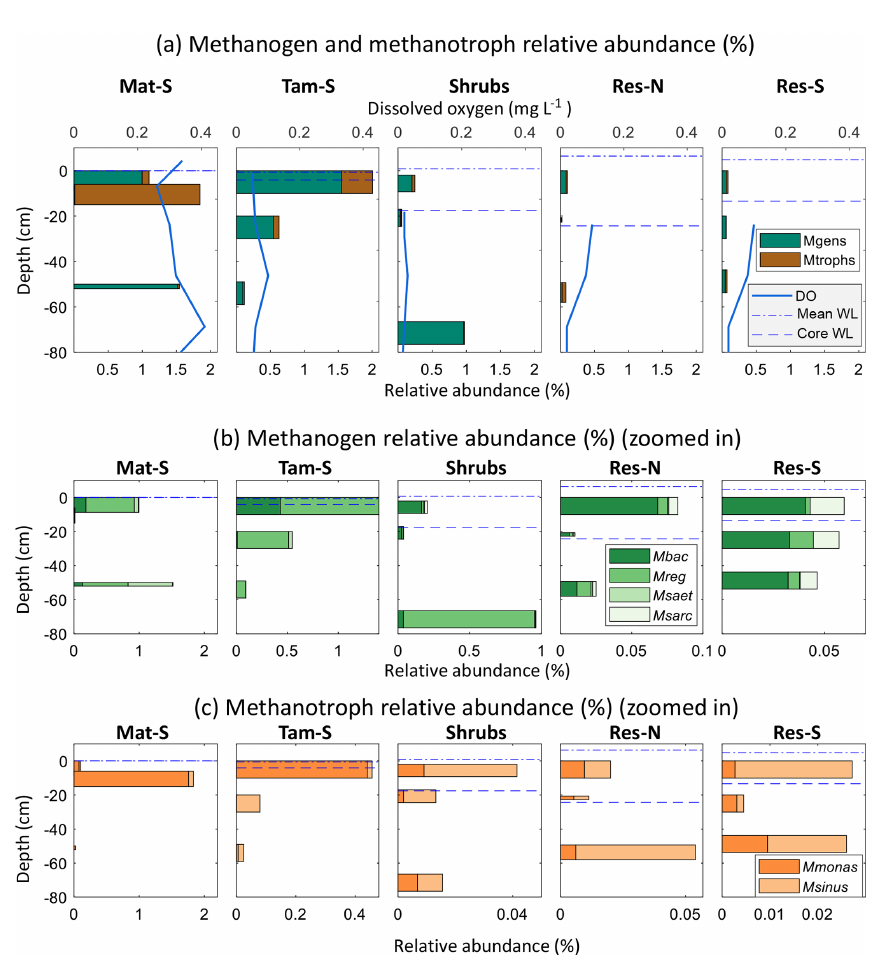
Figure 8. Relative abundances of methanogens and methanotrophs in the Mat-S, Tam-S, Shrubs, Res-N, and Res-S zones of the bog at different depths in the peat column, with the mean water level from June 2017 through August 2017 (mean WL) and the water level at time of sampling (core WL; in Mat-S these were both at 0cm; in Tam-S, the mean WL was at 0cm). Panel (a) shows overall methanogen (Mgens) and methanotroph (Mtrophs) abundances along with the average dissolved oxygen profile over the preceding month (from coring; see Methods). The observed genera of methanogens and methanotrophs are shown in panels (b) and (c) , respectively, with variable x axes. Methanobacterium (Mbac) and Methanoregula (Mreg) are hydrogenotrophic methanogens, and Methanosaeta (Msaet) and Methanosarcina (Msarc) are acetoclastic methanogens. Methylomonas (Mmonas) and Methylosinus (Msinus) are methanotrophs.